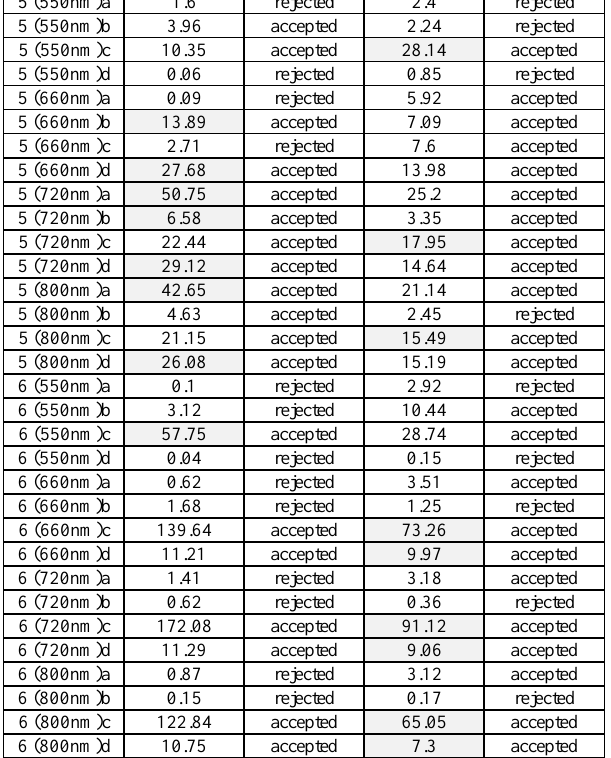
Table 4. Trend analysis results for 550 nm, 660 nm, 720 nm and 800 nm: Fc is the critical value for the highest freedom degree in the denominator and 1 or 2 for the numerator according to the polynomial degree. Fcalculated for each hypothesis test between the average against linear and quadratic polynomials and H0 has the conclusion for each hypothesis test. Fields filled by grey are accepted in a Sequential Analysis of